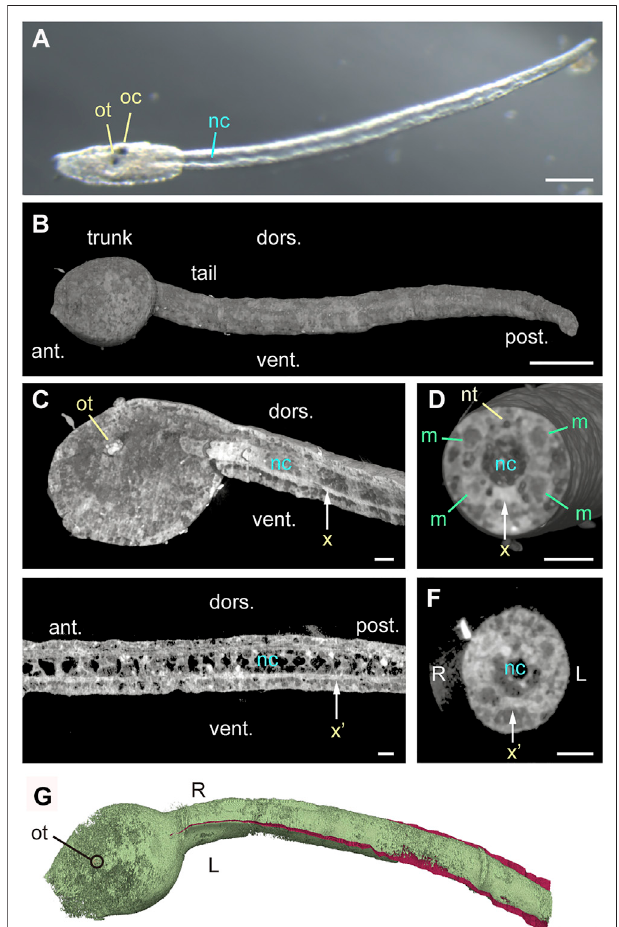
FIGURE1| Midplanehigh-densitystructuresin Ciona tadpolelarvae. (A) Bright fi eld image of 18-hpf larva with elongated tail. Scale bar, 100 μ m ot, otolith. oc, ocellus. nc, notochord. (B) Quantitative X-ray tomographic microscopy of an osmium-stained 16-hpf larva (left side view). ant., anterior. post., posterior. dors., dorsal. vent., ventral. Scale bar, 50 μ m. (C) Leftviewofmidsagittalsectionof16-hpflarva(cut-viewinsilico).Verticalarrow (x) indicating high-density ventral structure shows the position ofcutting plane in (D) .Scalebar,10 μ m. (D) Anteriorviewofaverticalcross-section.nt,neural tube. m, muscle cell. Scale bar, 10 μ m. (E) Left view of midsagittal section of an unstained 16-hpf larva acquired by quantitative X-ray tomographic microscopy. Vertical arrow (x ’ ) indicates a high-density structure, and the position of cutting plane in (F) . Scale bar, 10 μ m. (F) Anterior view of a tail vertical cross-section from an unstained 16-hpf larva. Scale bar, 10 μ m. (G) Dorsal view of osmium-stained 16-hpf larva shown in (B – D) , pseudo-colored green. The midsagittal plane is manually drawn in red in the tail. Scale bar, 50 μ m.